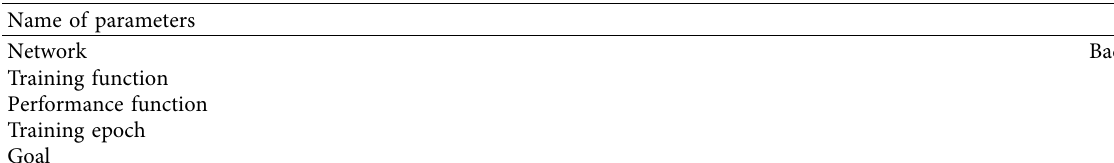
Table 8: The setting of training parameters for network.